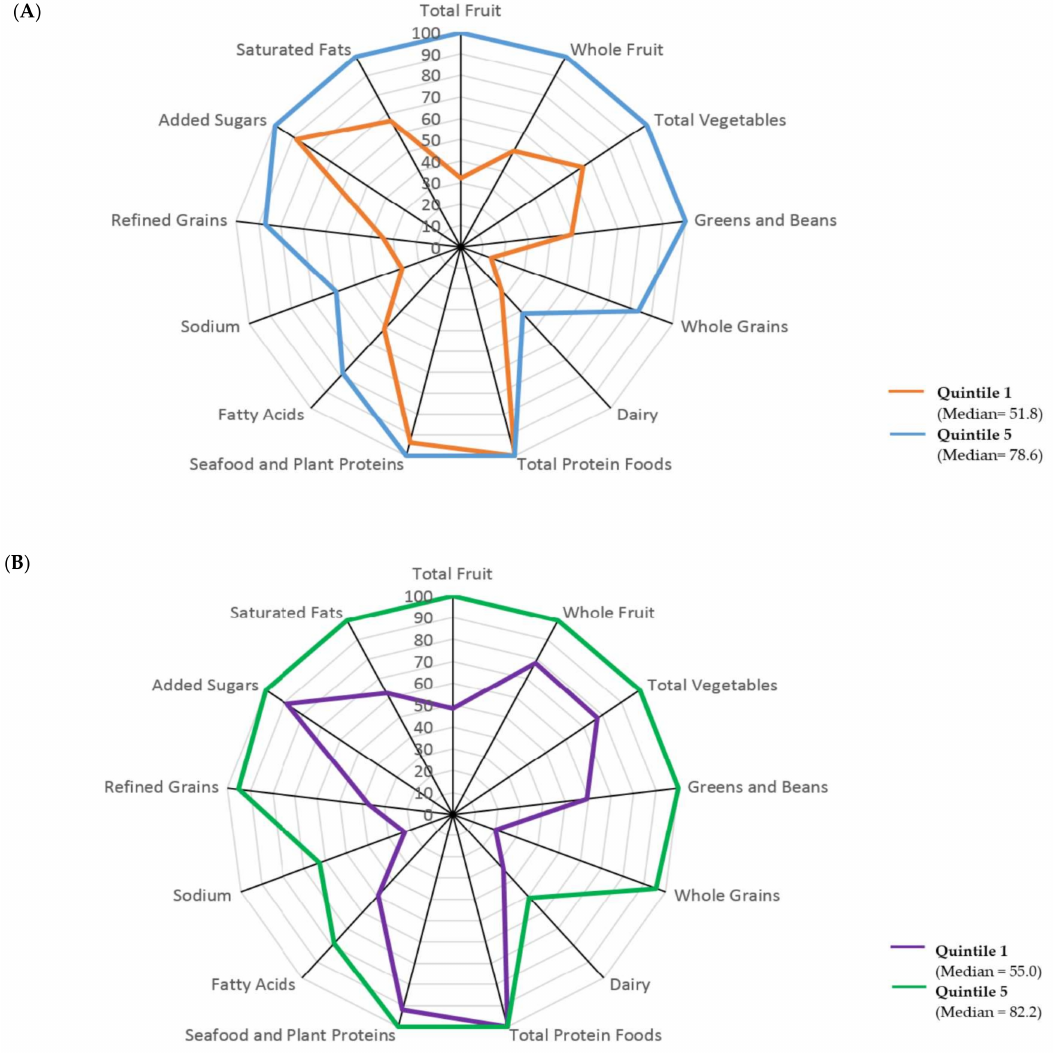
Figure 2. Total median scores and radar graphs of median component scores for ( A ) men and ( B ) women in Healthy Eating Index-2015 (HEI-2015) quintile 1 and quintile 5 in the Multiethnic